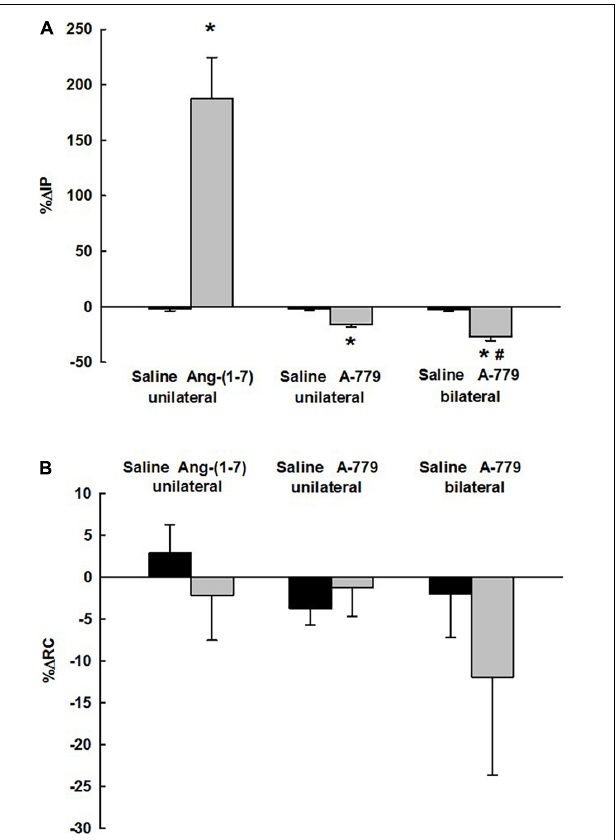
FIGURE 4 | (A) Percent changes in intravesical pressure (% (cid:49) IP) and (B) percent changes in renal conductance (% (cid:49) RC) in three different groups of rats ( n = 6/group) evoked by unilateral injection of saline (vehicle, 1 µ L) or angiotensin-(1–7) [Ang(1–7)] (5 nmol/ µ L, 1 µ L) into the lateral preoptic area (LPA); unilateral injection of saline or A-779 (50 nmol/ µ L, Mas receptor antagonist, 1 µ L) into LPA; bilateral injections of saline or A-779 (50 nmol/ µ L, Mas receptor antagonist, 1 µ L) into LPA. * P < 0.05 vs. saline, # P < 0.05 vs. unilateral A-779 into the LPA.